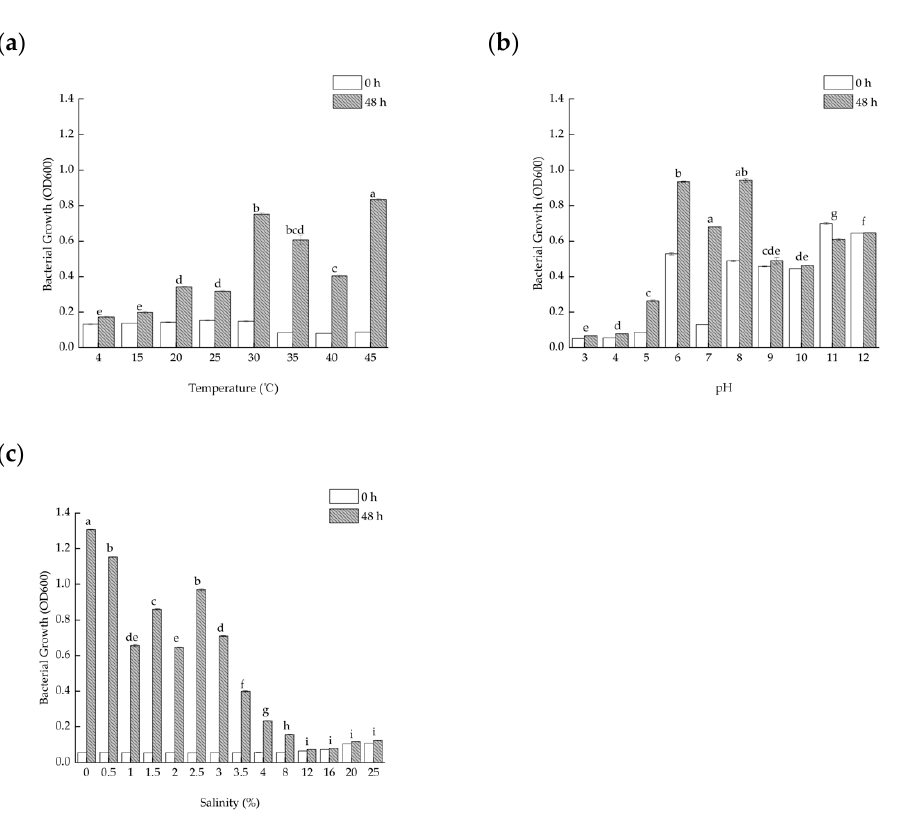
Figure 2. Optimal growth conditions for the strain TAW-CT127. ( a ) Growth of strain TAW-CT127 at different temperatures. ( b ) Growth of strain TAW-CT127 at different pH. ( c ) Growth of strain TAW-CT127 at different salinities. Values with completely different superscript letters in the same column are significantly different from each other, p < 0.05, and error bars indicate the standard error of the mean in triplicate experiments (using Tamhan correction).